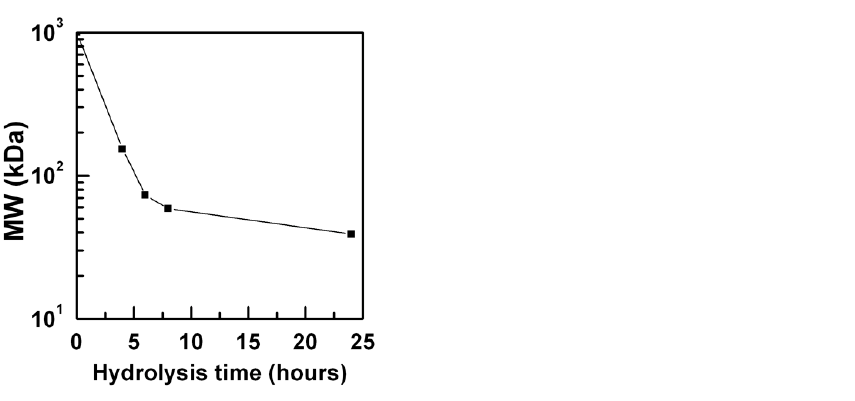
Figure 1. Reduction of GG molecular weight as a function of basic hydrolysis time. Table 1. The table report molecular weights, polydispersity index and yield % of obtained sam- ples.